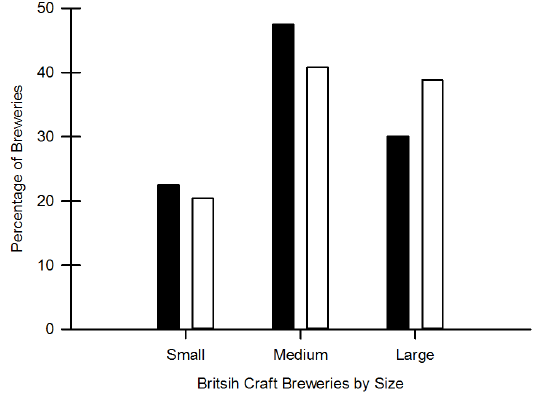
Figure 2. Brewery size distribution. Black bars: Urban-based craft brewers; white bars: Rural-based craft breweries. Small craft breweries having a batch capacity smaller than 1000 L; medium-sized craft breweries having a batch capacity greater than 1000 L, but smaller than 2000 L; and large craft breweries having a batch capacity greater than 2000 L.